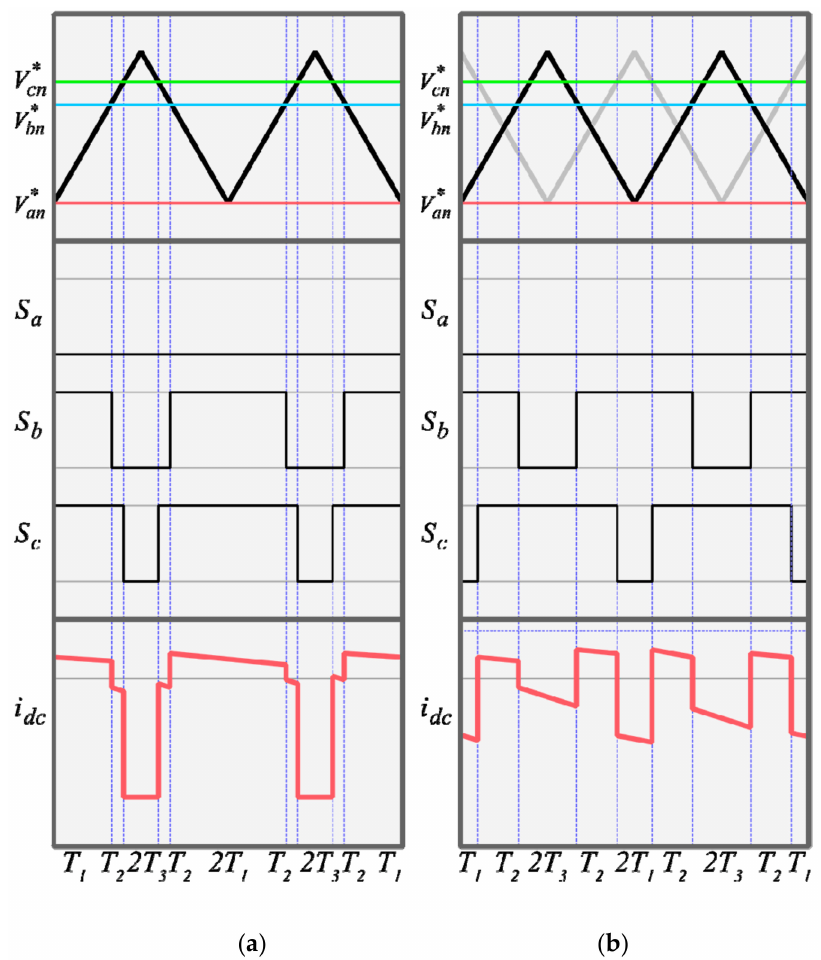
Figure 3. Detailed switching waveforms of the VSI: ( a ) Conventional method with no phase-shift; ( b ) proposed method with 180 ◦ phase-shift between two